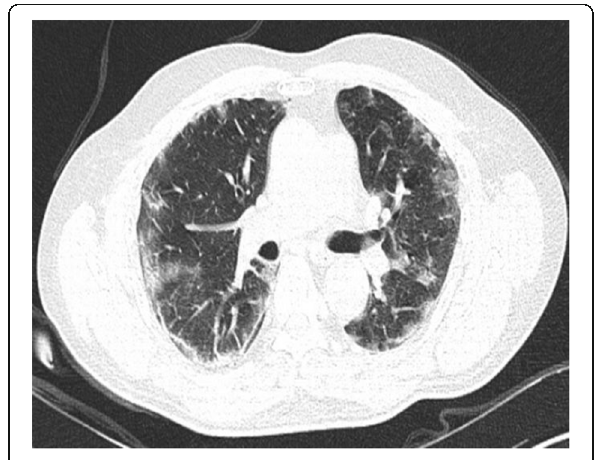
Fig. 7 CT scan showing typical features of Fig. 8 Chest X-ray showing evidence of mediastinal and